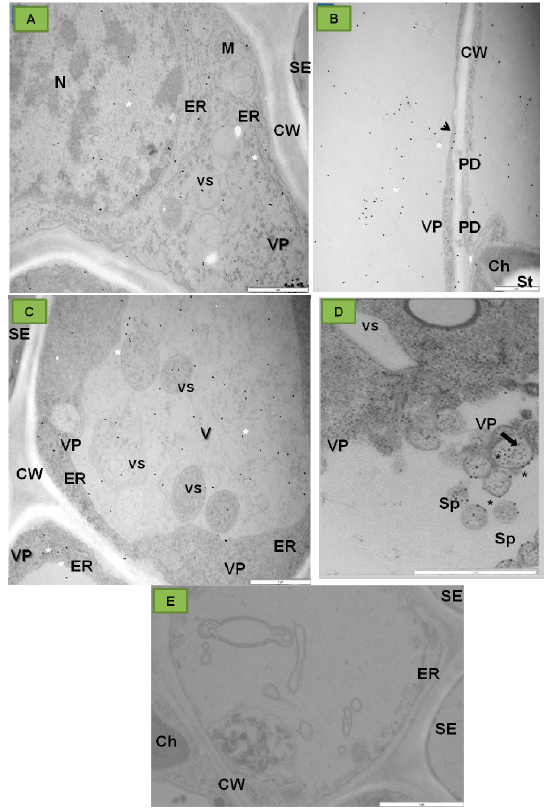
Figure 6. Immunogold localization of PDV coat protein (CP) in the tissues of the tobacco leaf blade, Samsun variety, 15 days post inoculation with PDV. ( A ) Labeling is observed in nucleus (N) and on the endoplasmic reticulum (ER) surface (*); ( B ) Colloidal gold particles (*) in vacuole of mesophyll cell. Labeling observed in cytoplasm (arrow) and by plasmodesmata; ( C ) Colloidal gold particles (*) in the companion cell protoplast. Labeling is observed both in vesicles and in the vacuole; ( D ) Colloidal gold particles (*) in the spherules’ membranes in a parenchyma cell; ( E ) Control tobacco plant phloem without of CP localization. Abbreviations: CW—cell wall, Ch—chloroplast,